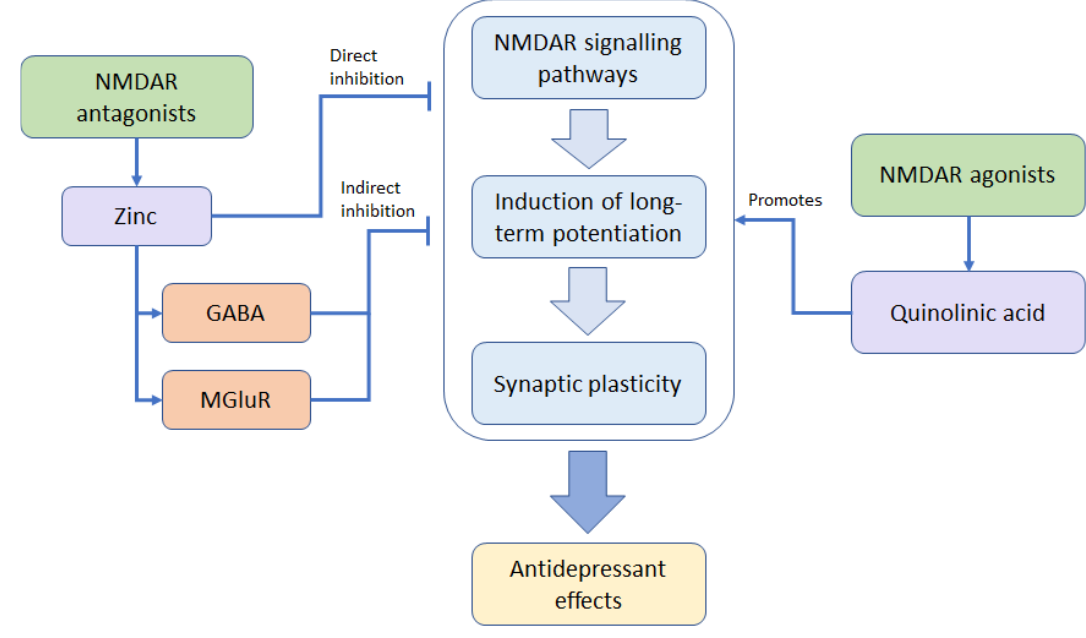
Figure 2 . Mechanism of NMDA receptor inhibition and promotion Figure explanation: NMDAR: N-methyl D-aspartate receptors, GABA: gamma-aminobutyric acid, MGluR: metabotropic glutamate